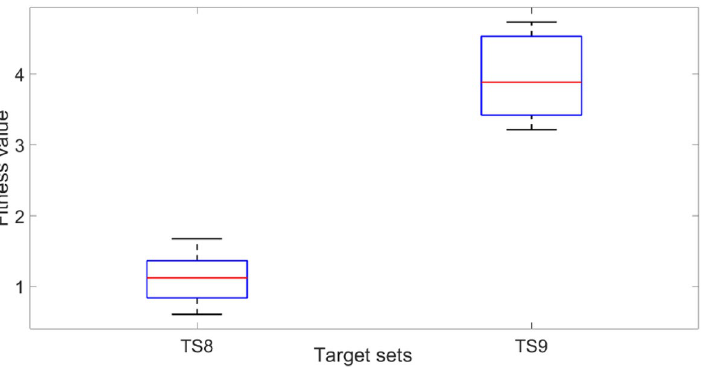
Figure 14. Comparison of fitness values for 20 voxel double void model for target deflection sets TS8 and TS9. Each box plot represents the results of 5 trials for each target set. The lower the fitness value, the closer the obtained deflection sets were to the target deflection set. The solid lines in the middle indicate the median fitness values, the top and bottom of the boxes represent the 25th and 75th